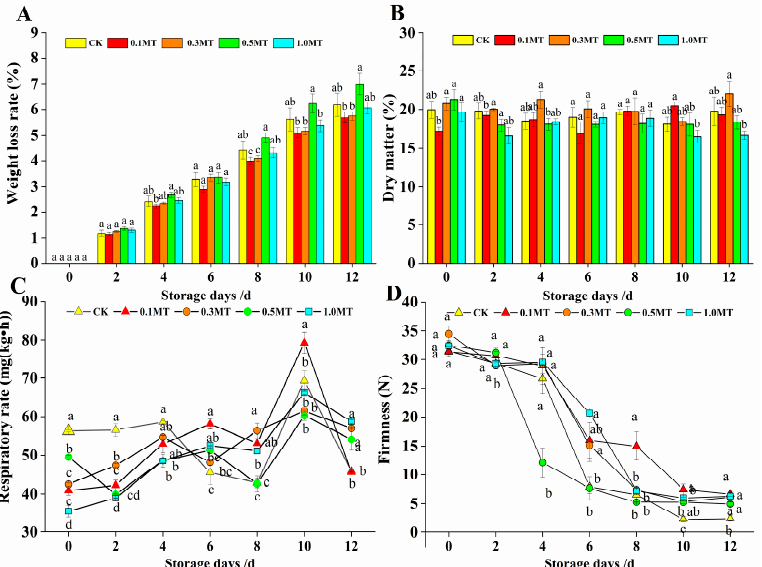
Figure 2. Effect of preharvest melatonin treatment on postharvest kiwifruit weight loss rate ( A ), dry matter ( B ), respiratory rate ( C ), and firmness ( D ). Values indicate the means of the replicates; error bars indicate the standard deviations of the mean (n = 3). Different lowercase letters indicate significant differences between treatments ( p < 0.05), while identical letters indicate no significant differences between treatments ( p > 0.05).